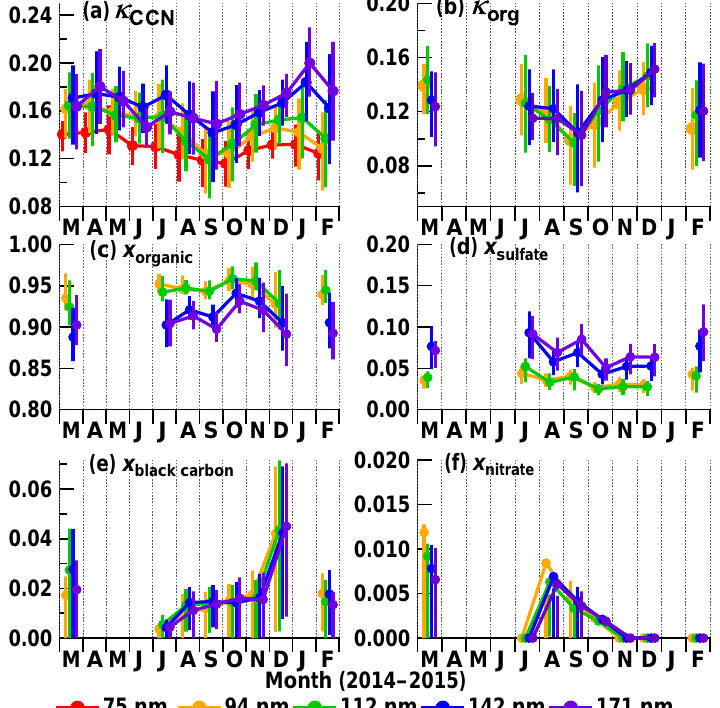
Figure 1. Seasonal variations of aerosol properties observed at the T3 site from March 2014 to March 2015, including (a) κ CCN ; (b) κ org ; and the size-resolved volume fraction of (c) organics; (d) sulfate, including ( NH 4 ) 2 SO 4 and NH 4 HSO 4 ; (f) refractory black carbon; and (e) nitrate. Data points are the monthly mean; error bars represent the 25th and 75th